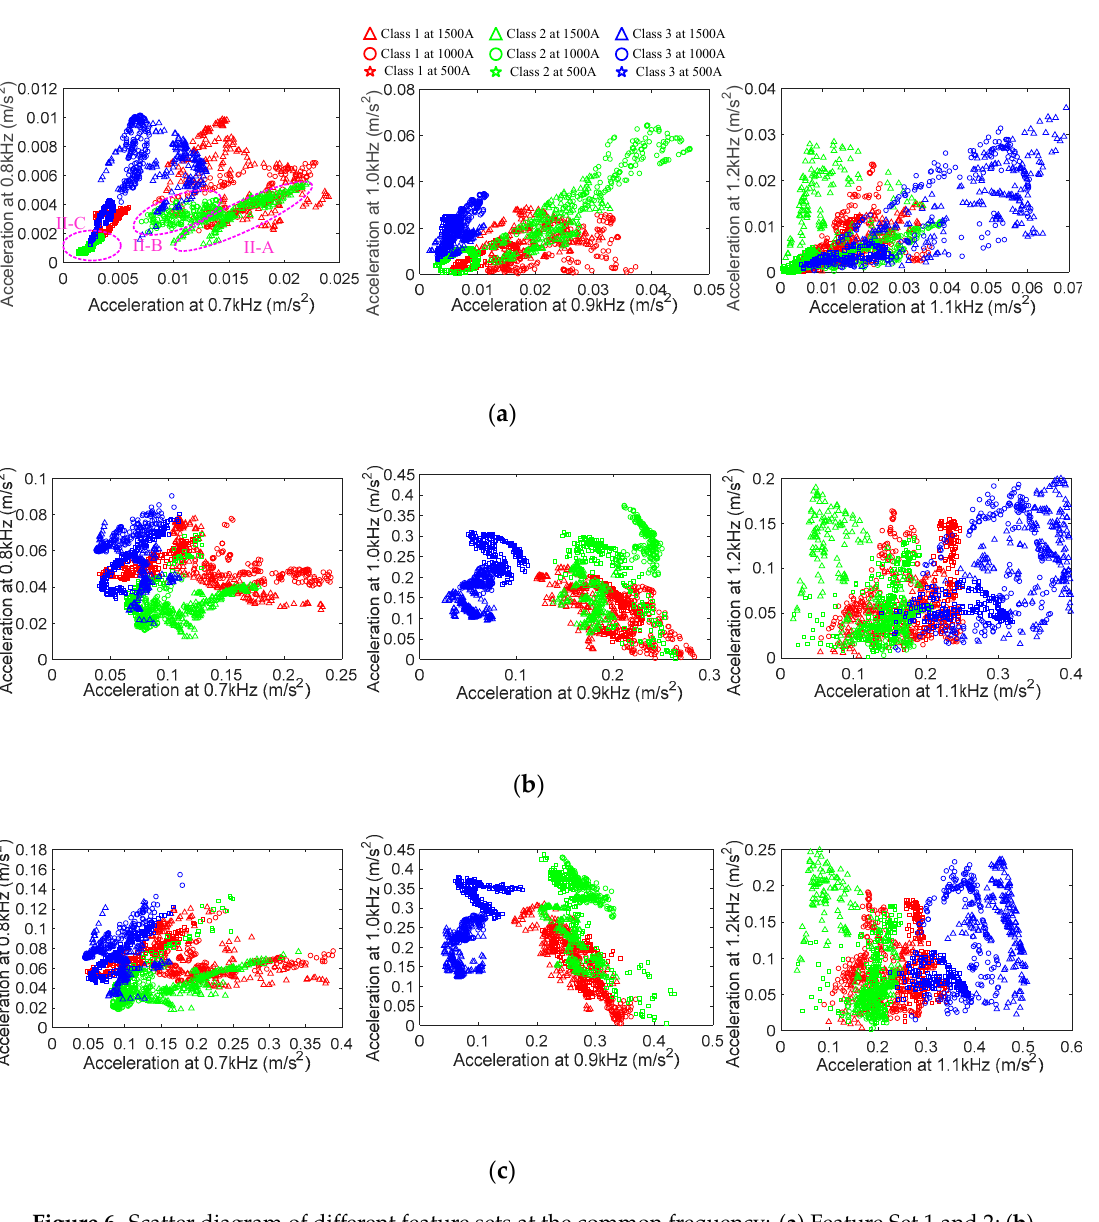
Figure 6. Scatter diagram of different feature sets at the common frequency: ( a ) Feature Set 1 and 2; ( b ) Feature Set 3; ( c ) Feature Set 4.